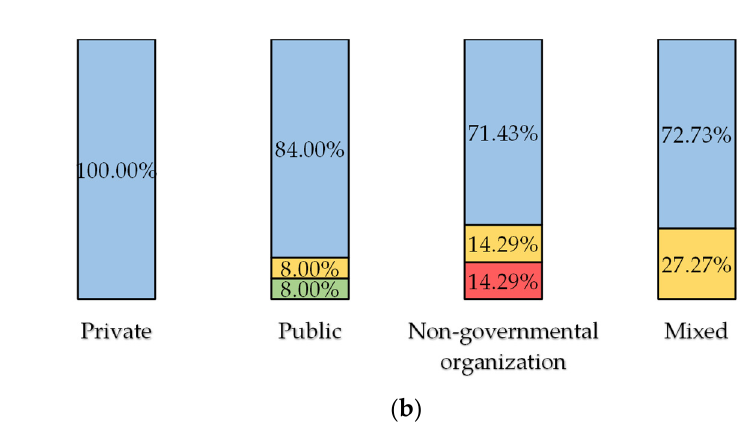
Figure 7. The scope and target organizations ERIH sites want to share their business models and revitalization processes in form of OI in general ( a ) and with differentiation among various ownership forms ( b ).